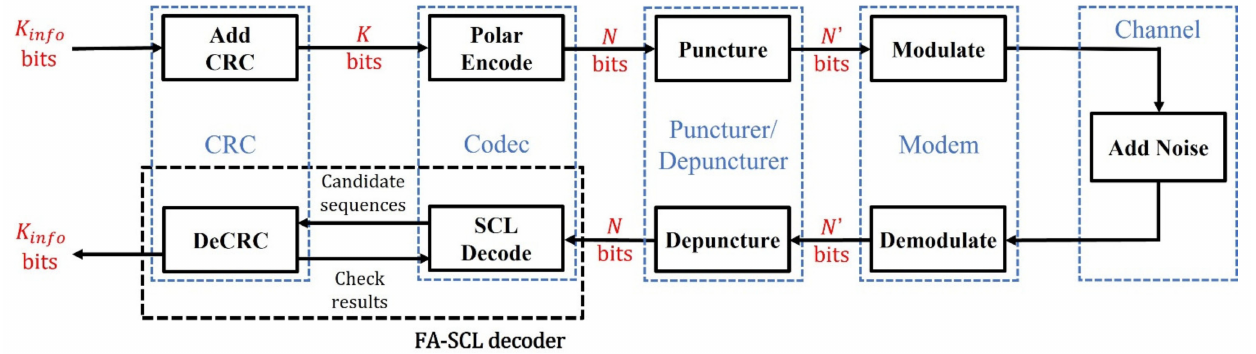
Figure 5. Block Diagram for modules and tasks in simulation for polar code system